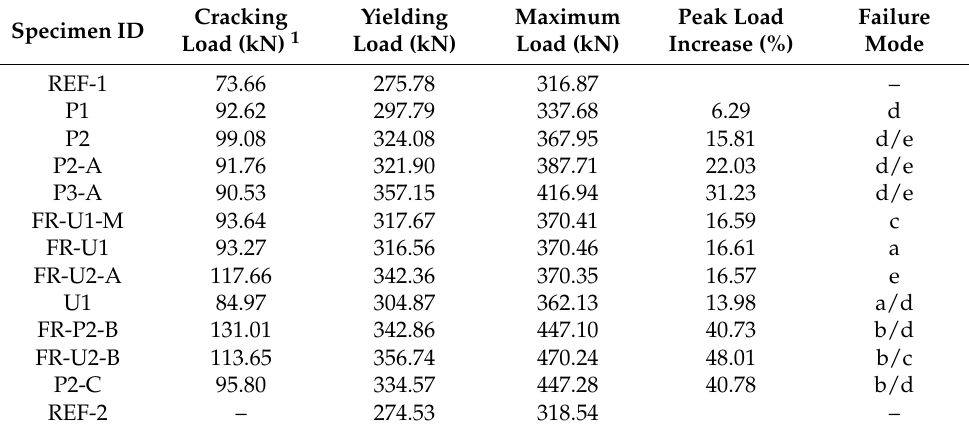
Figure 3. Failure modes of retrofitted beams. Table 2. Yielding Loads, Failure Loads and Failure Modes of the tested specimens.